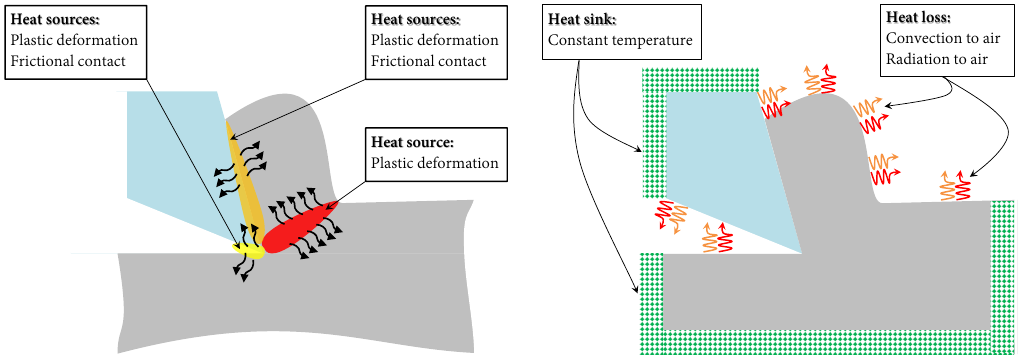
Figure 1. Illustration of heat sources and thermal boundary conditions in orthogonal